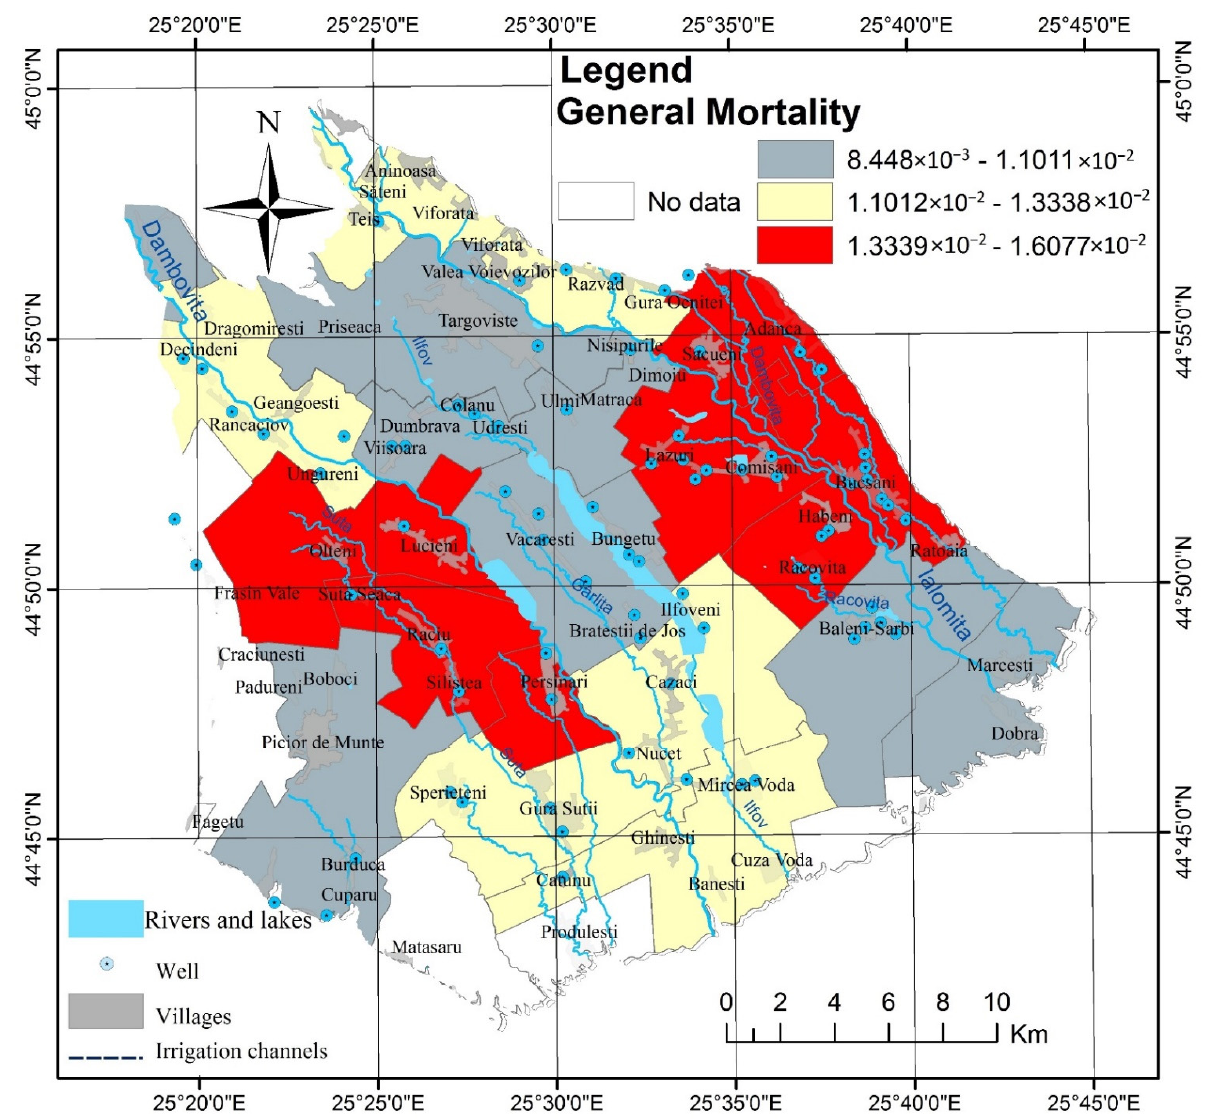
Figure 10. General mortality isn 2019 by administrative units in Târgovi ş te